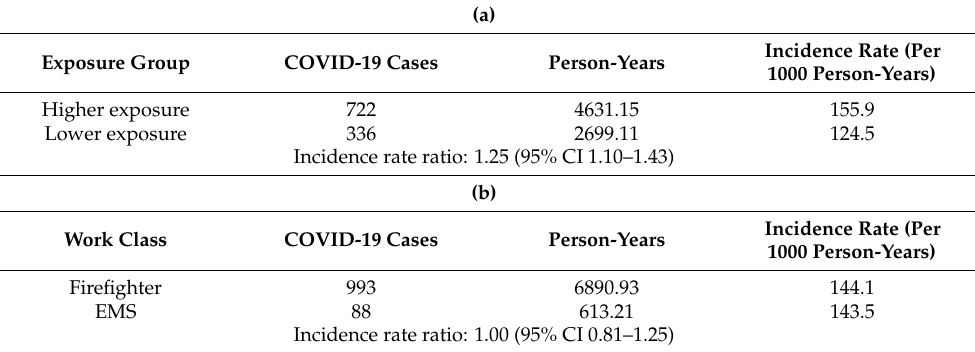
Figure 1. Unadjusted Kaplan–Meier survival curve and adjusted Cox Proportional Hazards regres- sion shows the unadjusted Kaplan–Meier survival curves with the hazard ratio for Arriving on 11 September 2001 vs. Arriving after 11 September 2001 from the adjusted Cox Proportional Hazards regression model in the panel. The model controls for race, sex, age on 1 March 2020, diabetes, interstitial lung disease, obstructive airways disease, obesity, hypertension, and smoking. Table 2. ( a ) Incidence Rates of COVID-19 by WTC Exposure History. ( b ) Incidence Rates of COVID-19 by Work assignment 1